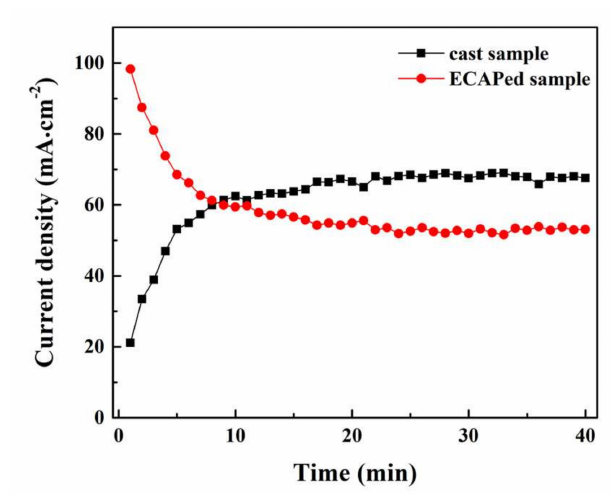
Figure 7. Evolution curves of the individual anodizing current density of cast and ECAPed samples.